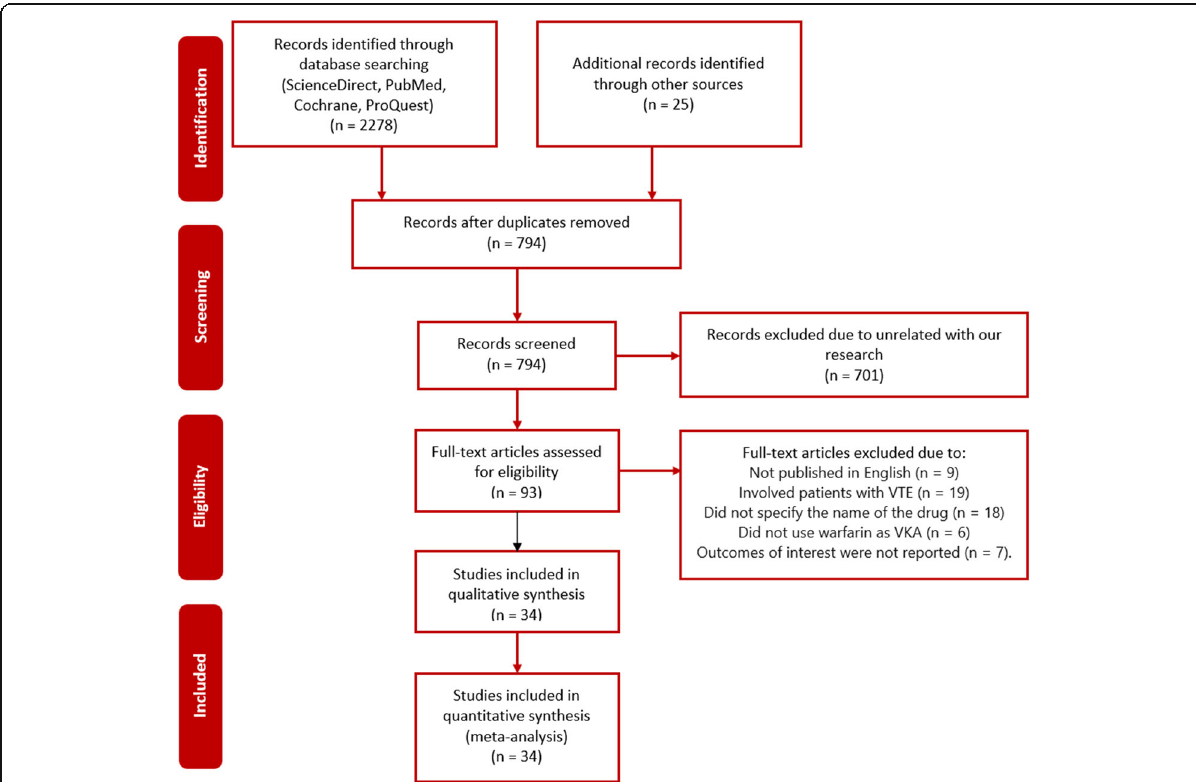
Fig. 1 Flow diagram summarizing the selection process of included studies. RCT = randomized controlled trial, VKA = vitamin K antagonist VTE = venous